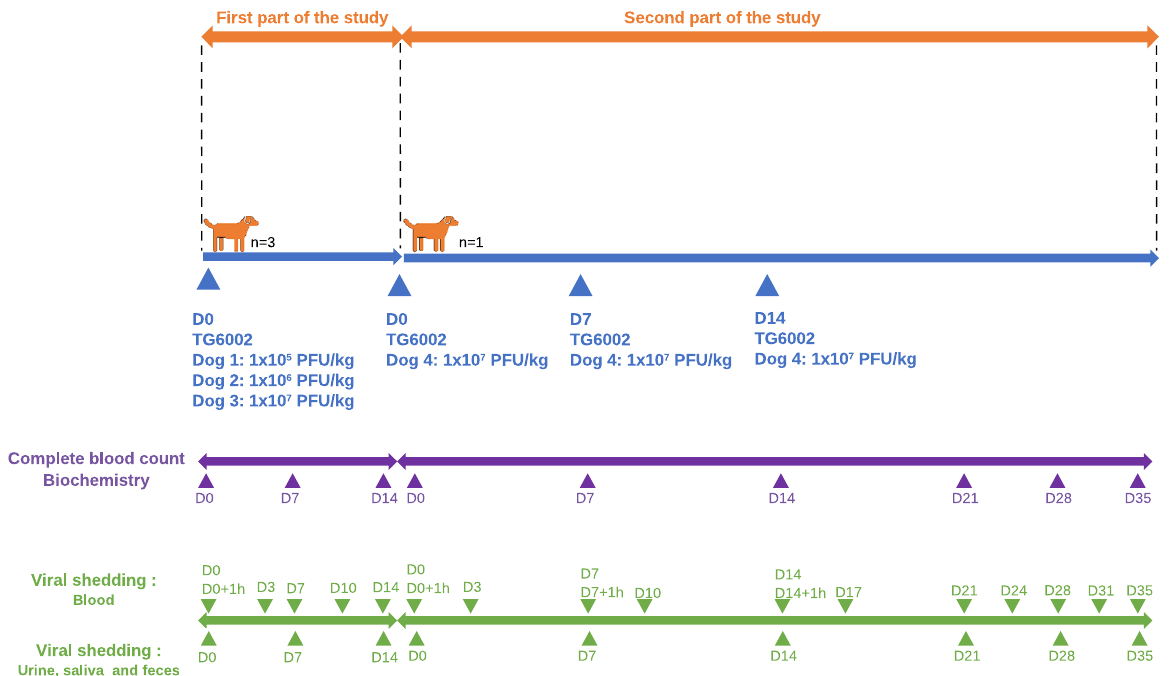
Figure 1. Study chart and sample collection for safety evaluation of intravenous administration of TG6002 in healthy